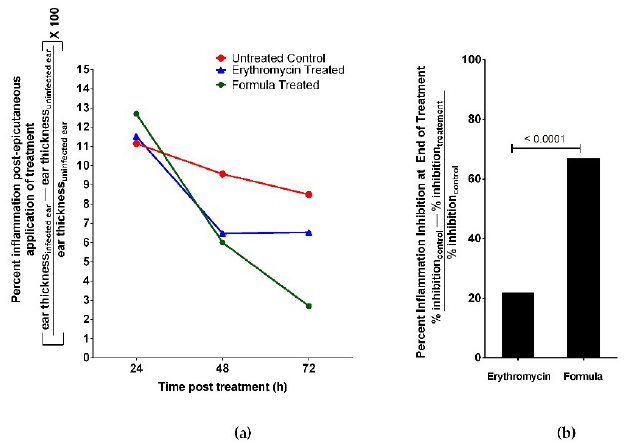
Figure 4. Oregano EO nanoemulsion showed stronger inhibition of inflammation than erythromycin control in acne mouse model. The acne mouse model was induced by intradermal injection of BALB/c mice’s left ears with 10 8 CFU in 20 mL of P. acne s. The mice’s right ears served as uninfected control. We applied epicutanously either oregano EO nanoemulsion or 2% Erythromycin solution on the infected mice ears. A third group of mice served as untreated control. ( a ) Percent inflammation was assessed post epicutaneous application of treatment as the difference between each mouse ear thickness of infected and uninfected ears. Oregano nanoemulsion showed higher rate of reduction in inflammation than 2% erythromycin during the treatment time interval. ( b ) Oregano nanoemulsion showed significantly higher percent of inhibition of inflammation (>60%) at the end of treatment period than 2% erythromycin control (20%). Data represented as mean ± standard deviation of three independent experiments, total mice per group 15 mice. We used t ‐test for comparing groups with p < 0.05 consider significant.